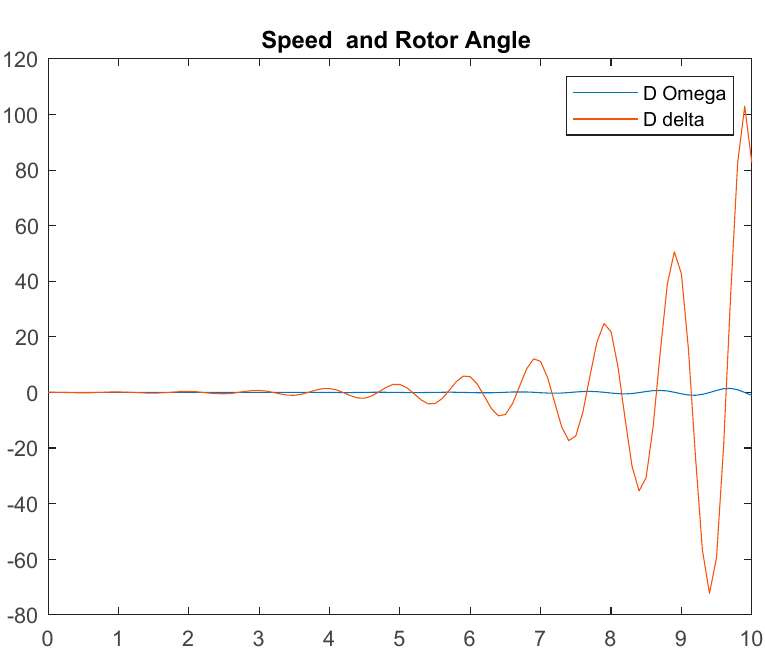
Figure 4. The system response in which there is a linear relationship between instability and time.